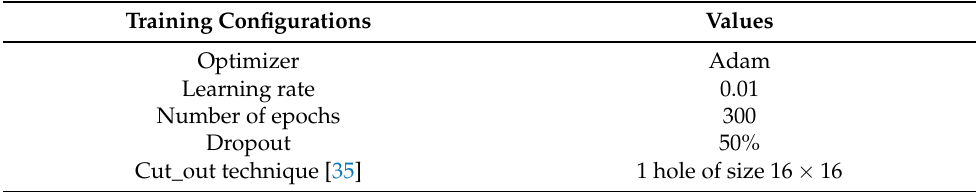
Table 4. Training configurations for the VGG-16 model